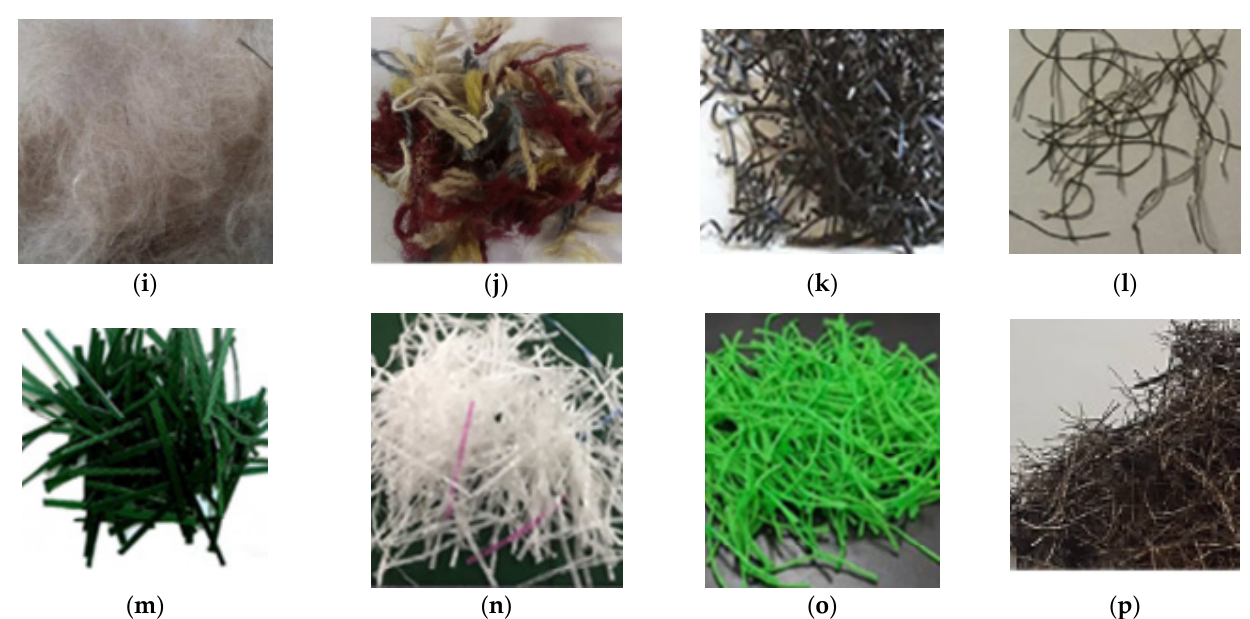
Figure 1. Various recycled-waste fibers used in cementitious composites. ( a ) Waste plastic fiber [74], ( b ) Waste recycled polyethylene terephthalate fiber [75], ( c ) Waste recycled PET/PE fibers from packaging [76], ( d ) Waste recycled PE/PP fibers from artificial turf [76], ( e ) Virgin PP draw-wired fibers [76], ( f ) Textile waste fiber [53], ( g ) Kraft pulp Fiber [53], ( h ) Waste polypropylene carpet fibers [77], ( i ) Waste carpet face fibers [78], ( j ) Waste carpet fibers [79], ( k ) Waste steel scrap [80], ( l ) Tire-recycled steel fibers [80], ( m ) Waste recycled plastic fiber [38], (n) Waste recycled woven plastic sack fiber [18],